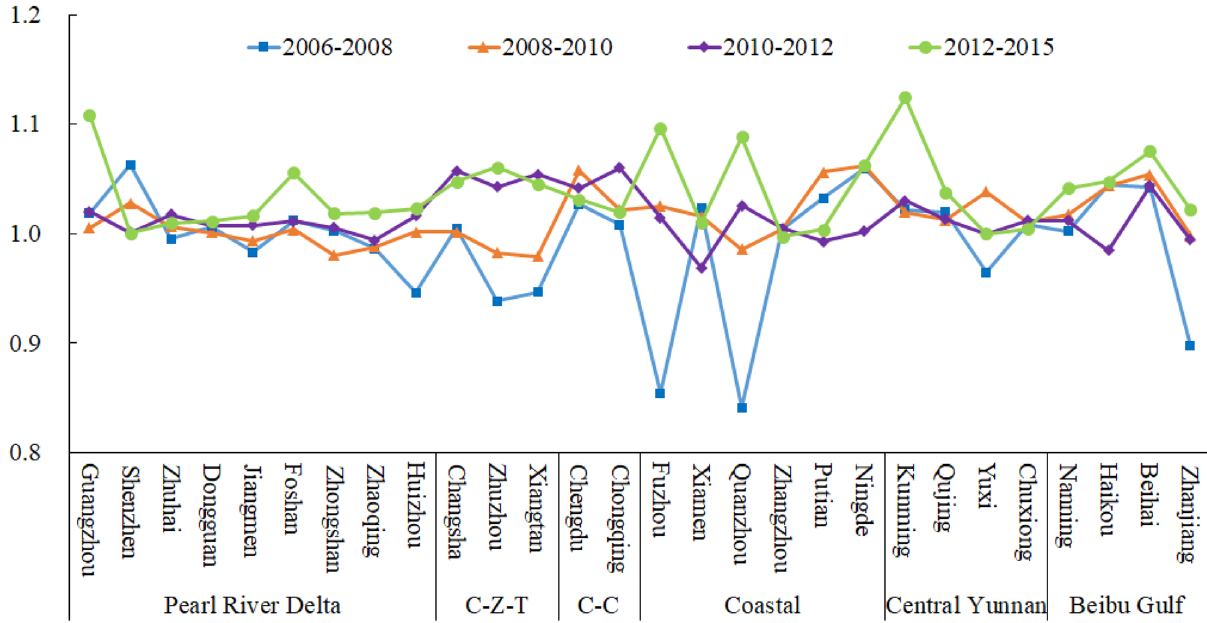
Figure 1. Changes in GTFP of the Pan-Pearl river delta urban agglomeration. Notes : C-Z-T means Chang-zhu- tan urban agglomeration. C–C means Chengdu-Chongqing urban